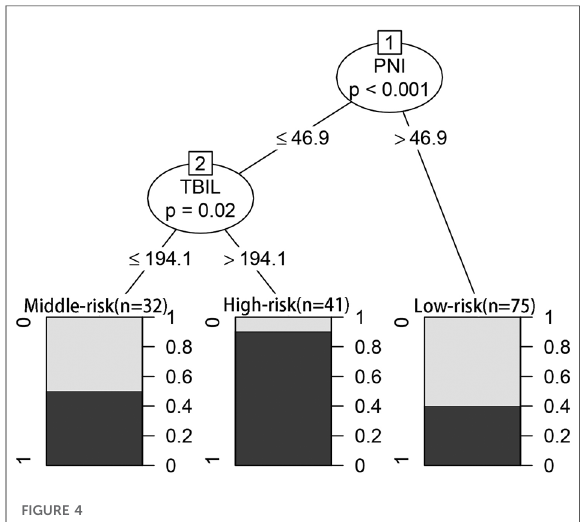
FIGURE 4 Prediction model for overall complication using CART